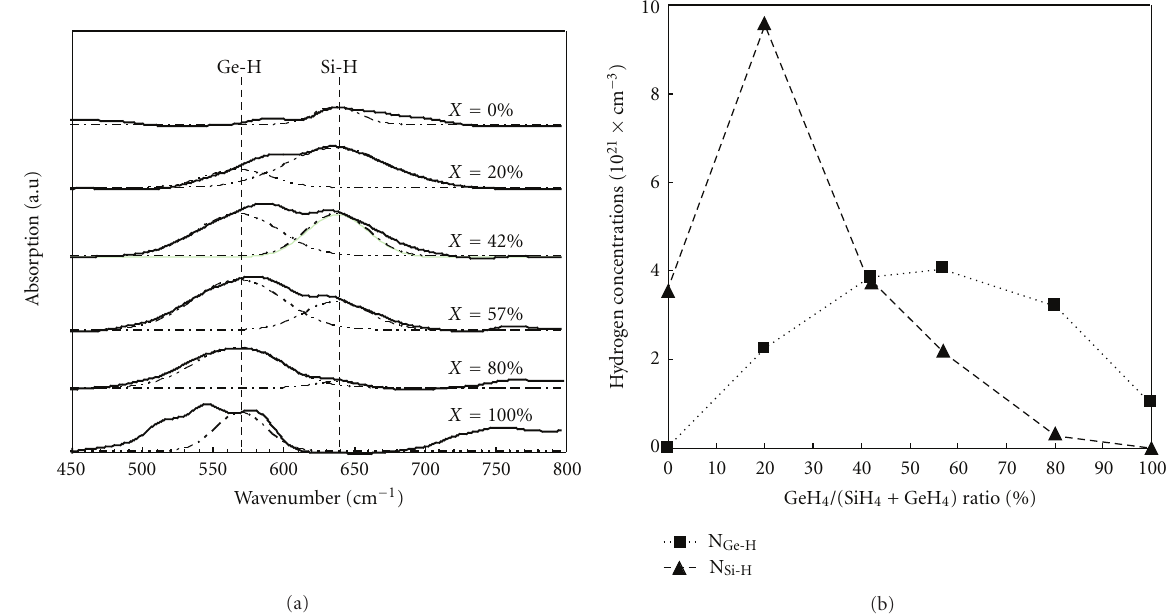
Figure 4: (a) Infrared coe ffi cient absorption spectrums of the wagging mode of the a-SiGe:H films deposited at di ff erent germanium concentrations. (b) Variation of bonded hydrogen concentration in di ff erent configurations as function of the gas ratio.